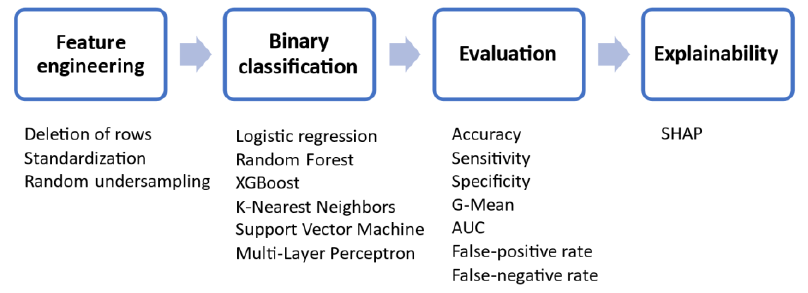
Figure 2. Workflow of the proposed AI methodology.